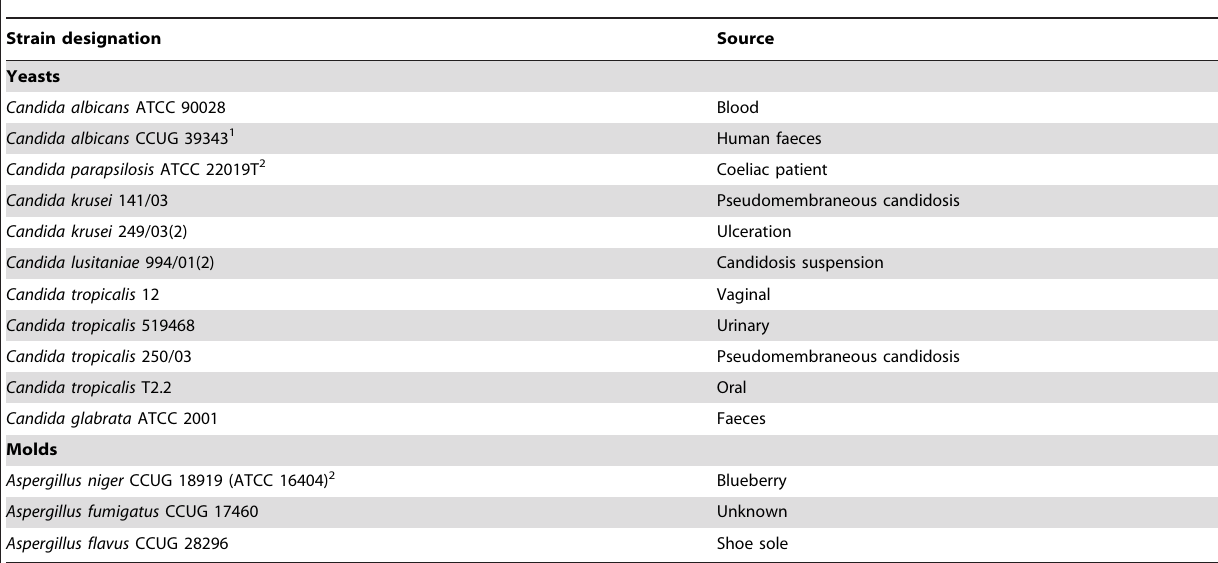
Table 1. Strains used for susceptibility testing and their